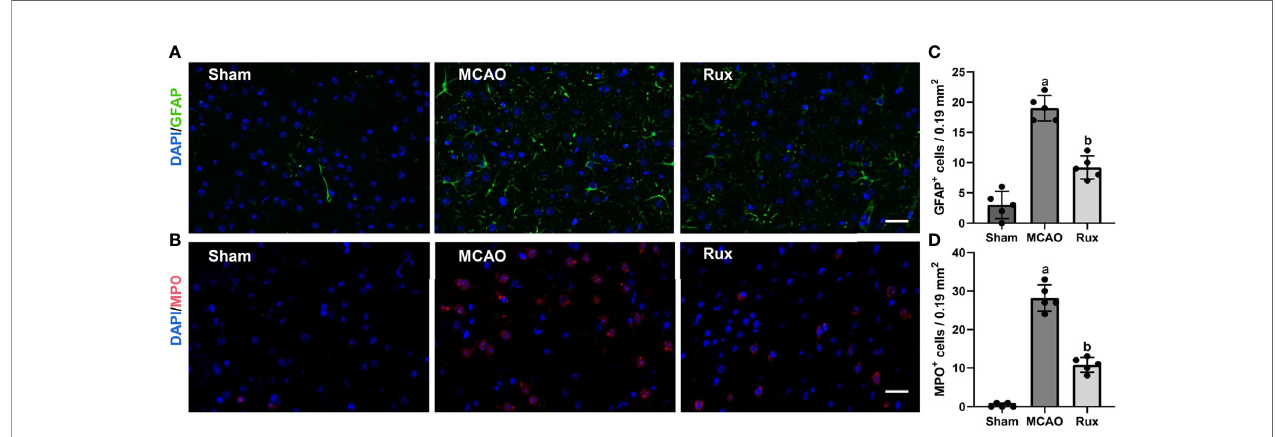
FIGURE 6 | Rux treatment decreased the number of GFAP + and MPO + cells in the ischemic penumbra 3 days after MCAO. (A, C) Representative immunostaining of GFAP and MPO in the penumbra region. (C, D) Quanti fi cation results of GFAP + and MPO + cells in the peri-ischemic region. Means ± SD. n = 5. a P < 0.01 versus sham; b P < 0.01 versus vehicle; Scale bar: